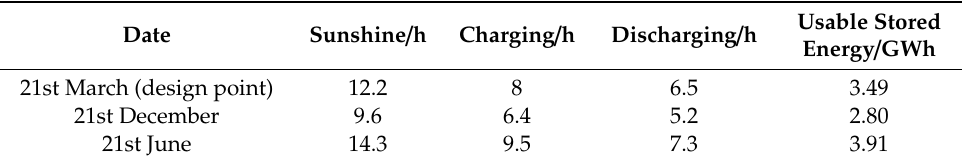
Table 4. Chosen days for winter and summer behavior.